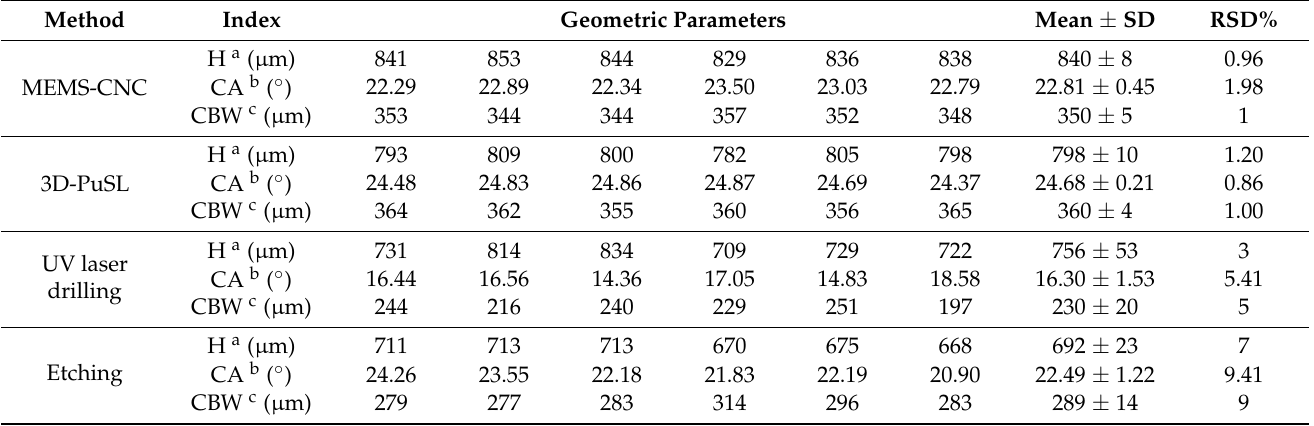
Table 5. Geometric parameters of male mold prepared by different methods ( n =